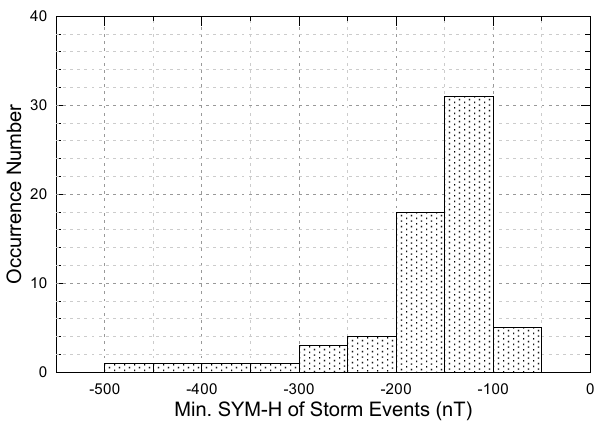
Fig. 1. Histogram of minimum SYM-H index for the events used in ANN model